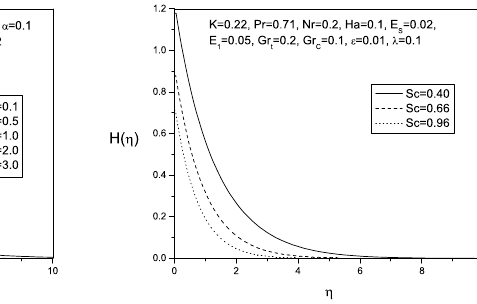
Figure 11. Variation of concentration profiles with η for different values of Sc and α = 0 .